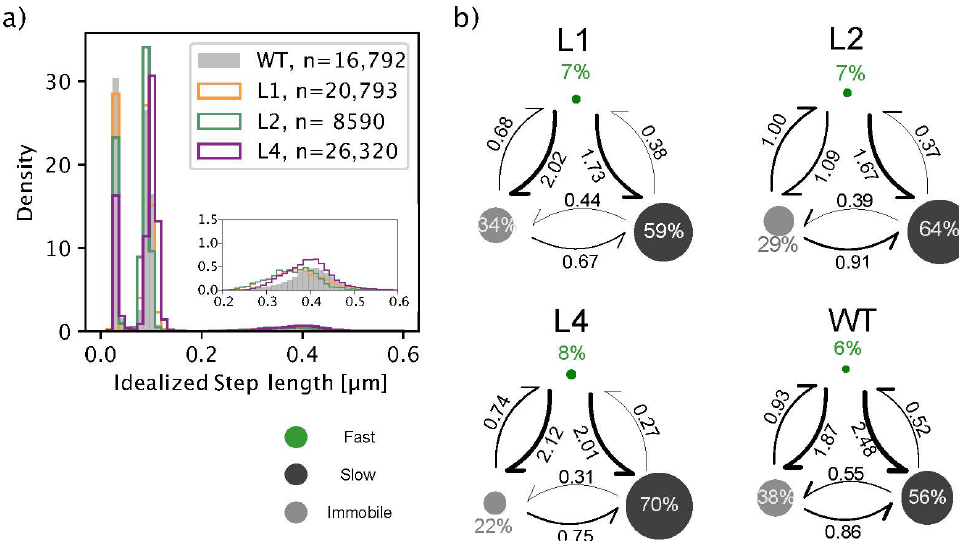
Figure 3. ( a ) Histograms of idealized step length of diffusional states segmented by HMM of step lengths). ( b ) Quantitative model of 3 diffusional states depicting the interconversion rates of TLL and its dependence on mutation in the lid in application conditions. The occupancy percentages are given as the sizes of the circles and the numbers in the circles. The rates between the states are written above the arrows and given in s − 1